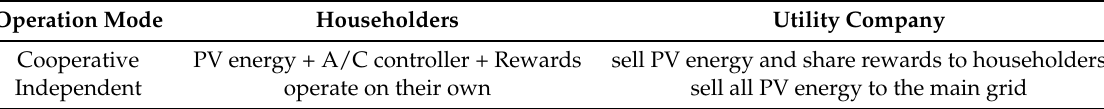
Table 3. Comparison of cooperative mode and independent mode.